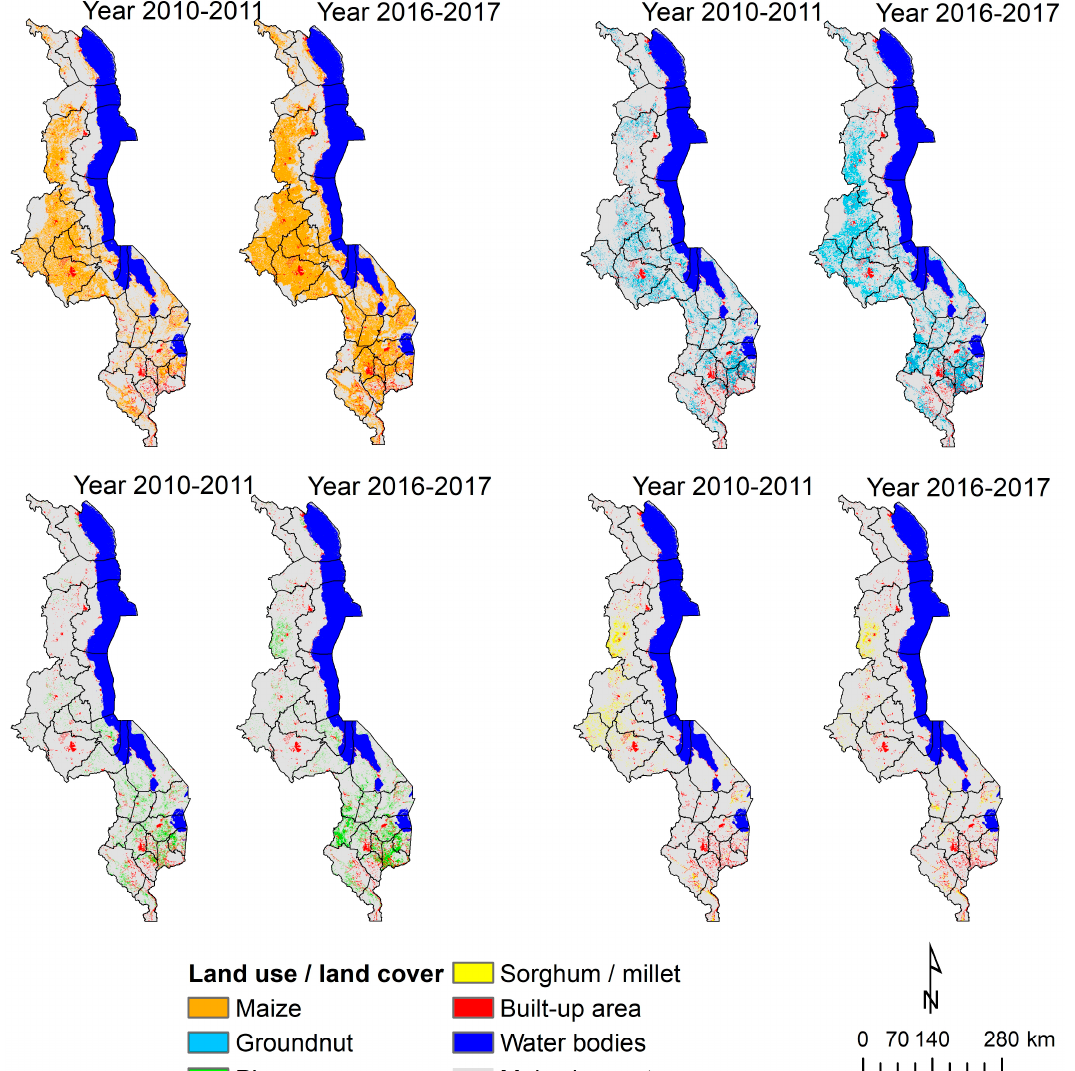
Figure 5. Spatial distribution of major cropping pattern for both crop year 2010–2011 and crop Figure 5 . Spatial distribution of major cropping pattern for ( a ) crop year 2010–2011 and ( b ) crop year year 2016–2017.